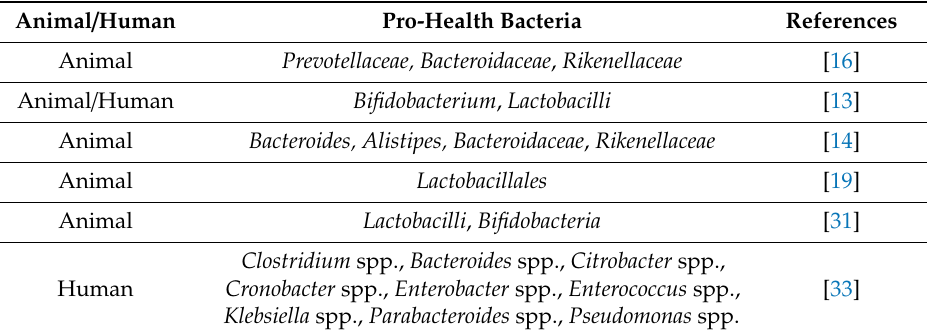
Table 1. The e ff ect of curcumin on health-promoting bacteria in the intestinal microflora. Animal /